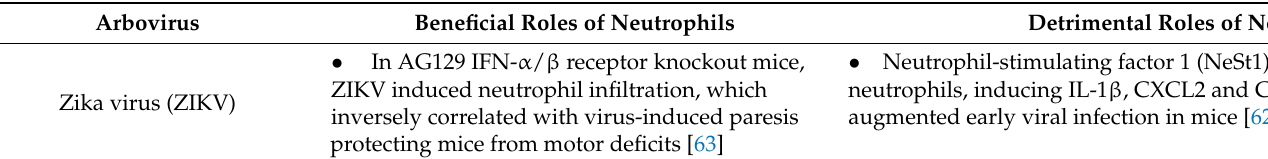
Table 1. Summary of the roles of neutrophils during various arboviral